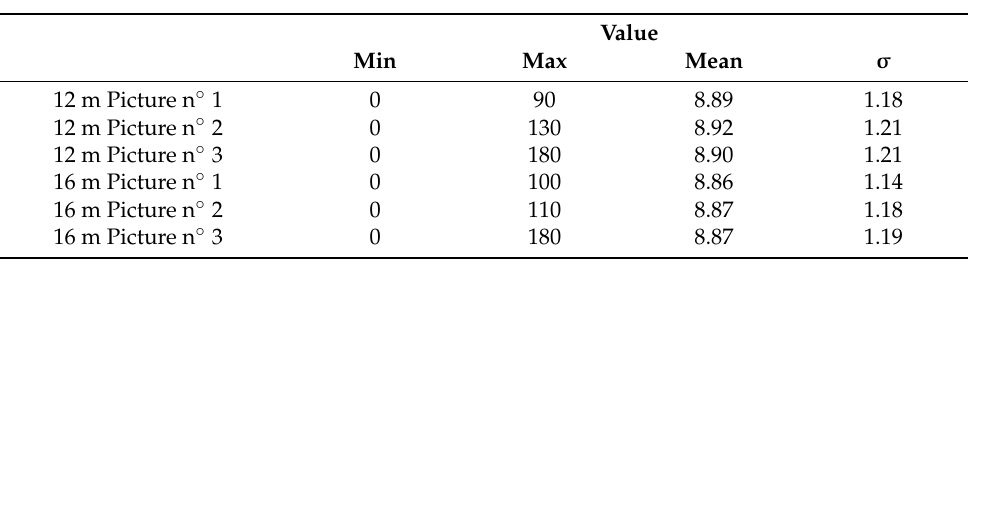
Table 1. Description of VI results for each